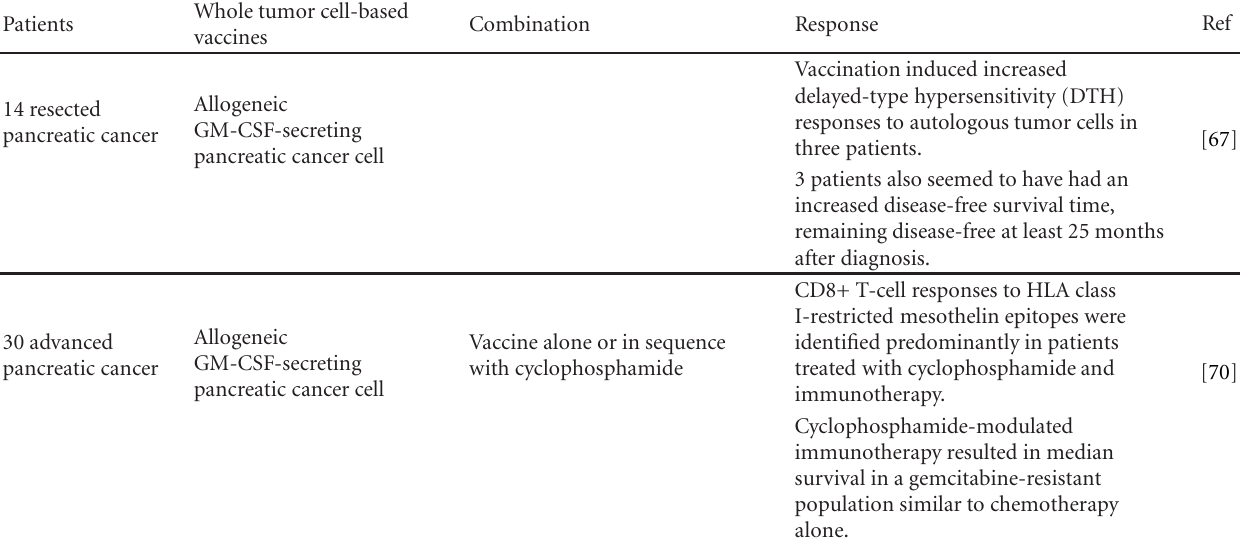
Table 2: Whole tumor cell-based